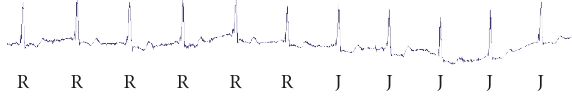
Figure 5: Raw tracing of ECG for patient 124 in the MIT-BIH database with junctional escape beats: a sequence of ECG is shown containing both right bundle branch block (R) and junctional pre- mature (J) beats. The morphological di ff erences between the two classes of beats are again subtle. This excerpt corresponds to time 4 : 39 in the